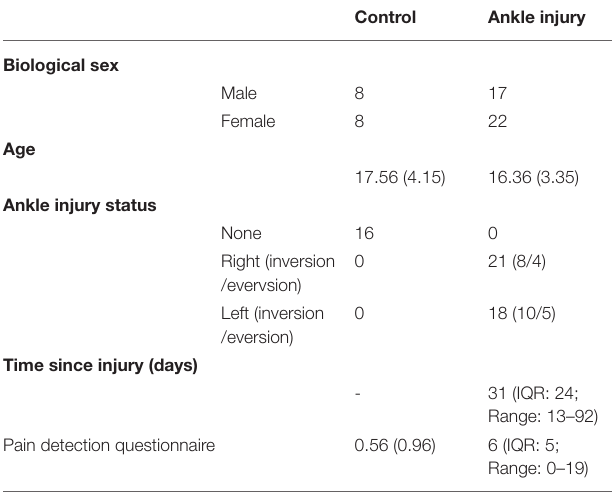
TABLE 1 | Descriptive